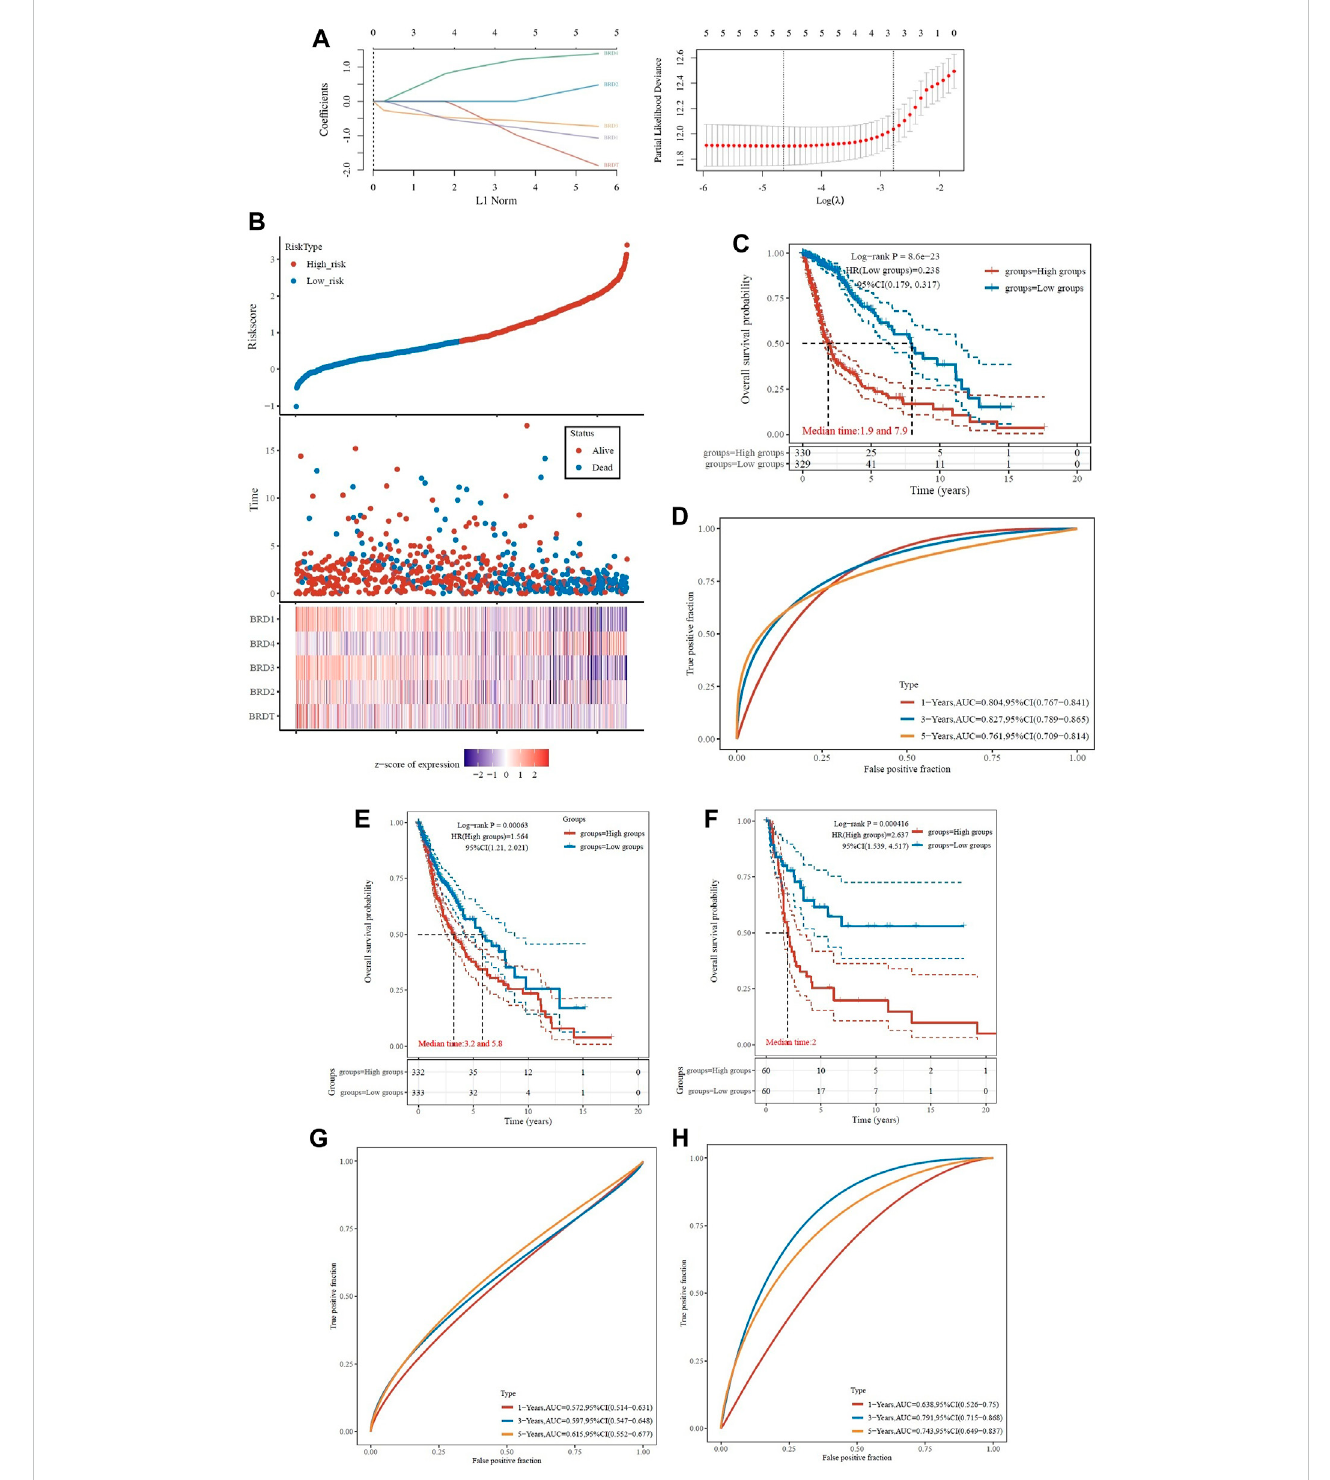
FIGURE 7 Analysis of prognostic assessment of BET genes in TCGA dataset (A – D) , and external validation of BRD4 gene signature in ICGC training set (E – H) . Patients were divided into low-risk and high-risk groups. (A) LASSO regression analysis was performed on BET genes to calculate the correlation coef fi cients. Coef fi cients of selected features are shown by lambda parameter; Partial likelihood deviance versus log( λ )was drawn using LASSO Cox regression model. (B) TheLASSOalgorithmwasusedtogenerateriskscoresforthetrainingcohortfromTCGA.RelationshipofBETproteinsexpressionwithriskscore,survival time, and survival status were shown in the training cohort. (C) Distribution of KM survival curves for differential expression of BET proteins in the training cohort. (D) ROC curve and AUC of BET proteins signature classi fi cation. (E) Kaplan-Meier survival analysis of patients in different risk groups from TCGA dataset. (F) Kaplan-Meiersurvivalanalysis ofpatientsindifferentriskgroupsfromICGCtrainingset. (G) TheROCcurvesforriskscoreinTCGAdataset. (H) The ROC curves for risk score in ICGC training set. The higher values of AUC corresponding to higher predictive power.